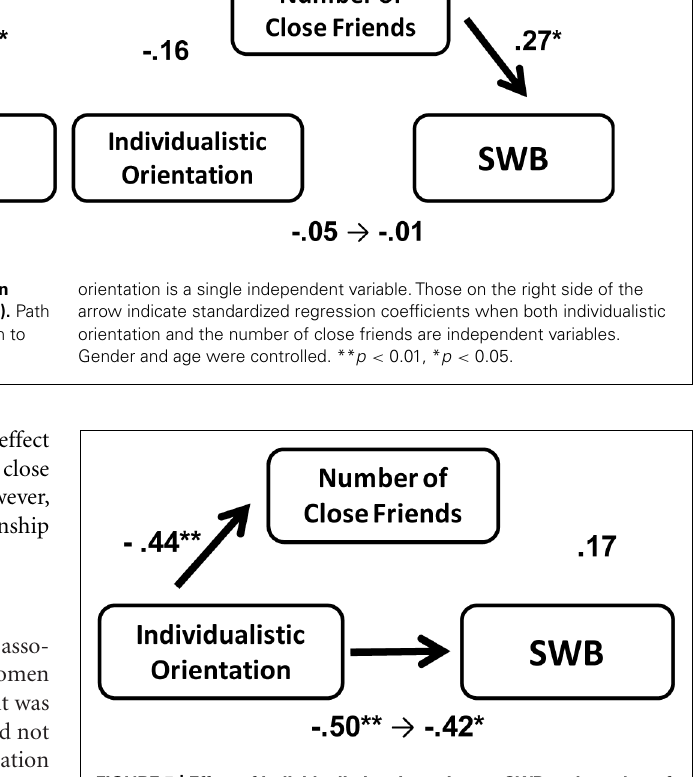
FIGURE 5 | Effect of individualistic orientation on SWB and number of close friends in Japanese individualistic-oriented environment (Study 2). Path coefficients on the left side of the arrow from individualistic orientation to SWB indicate standardized regression coefficients when individualistic orientation is a single independent variable.Those on the right side of the arrow indicate standardized regression coefficients when both individualistic orientation and the number of close friends are independent variables. Age was controlled. ** p < 0.01, * p < 0.05.